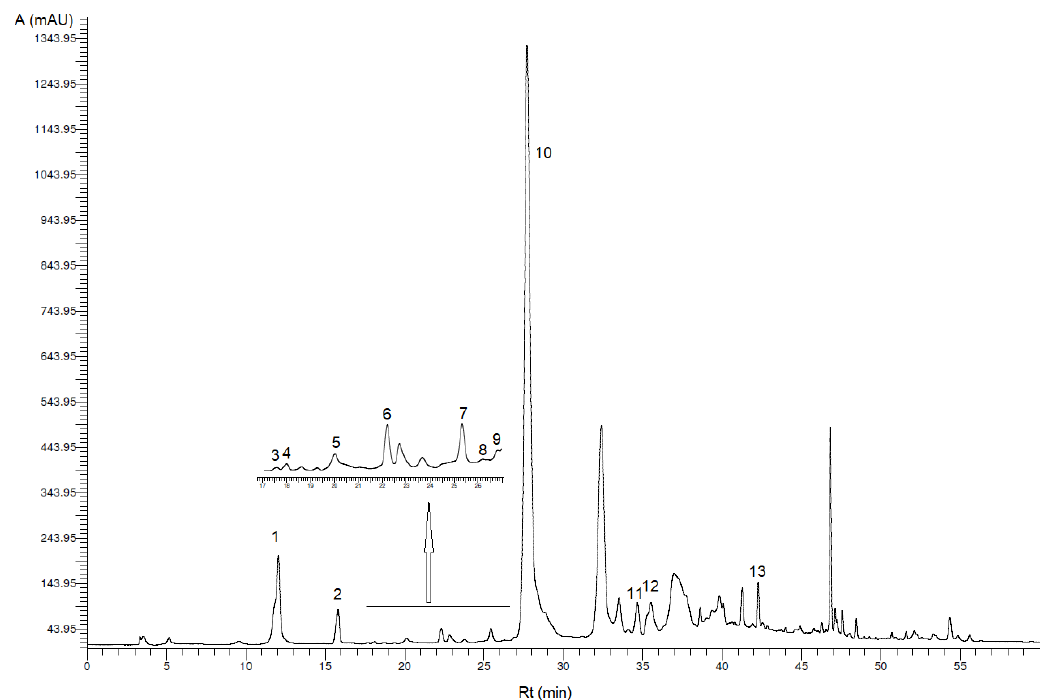
Figure 1. High-performance liquid chromatography (HPLC) chromatogram of PE (phenolic extract) at